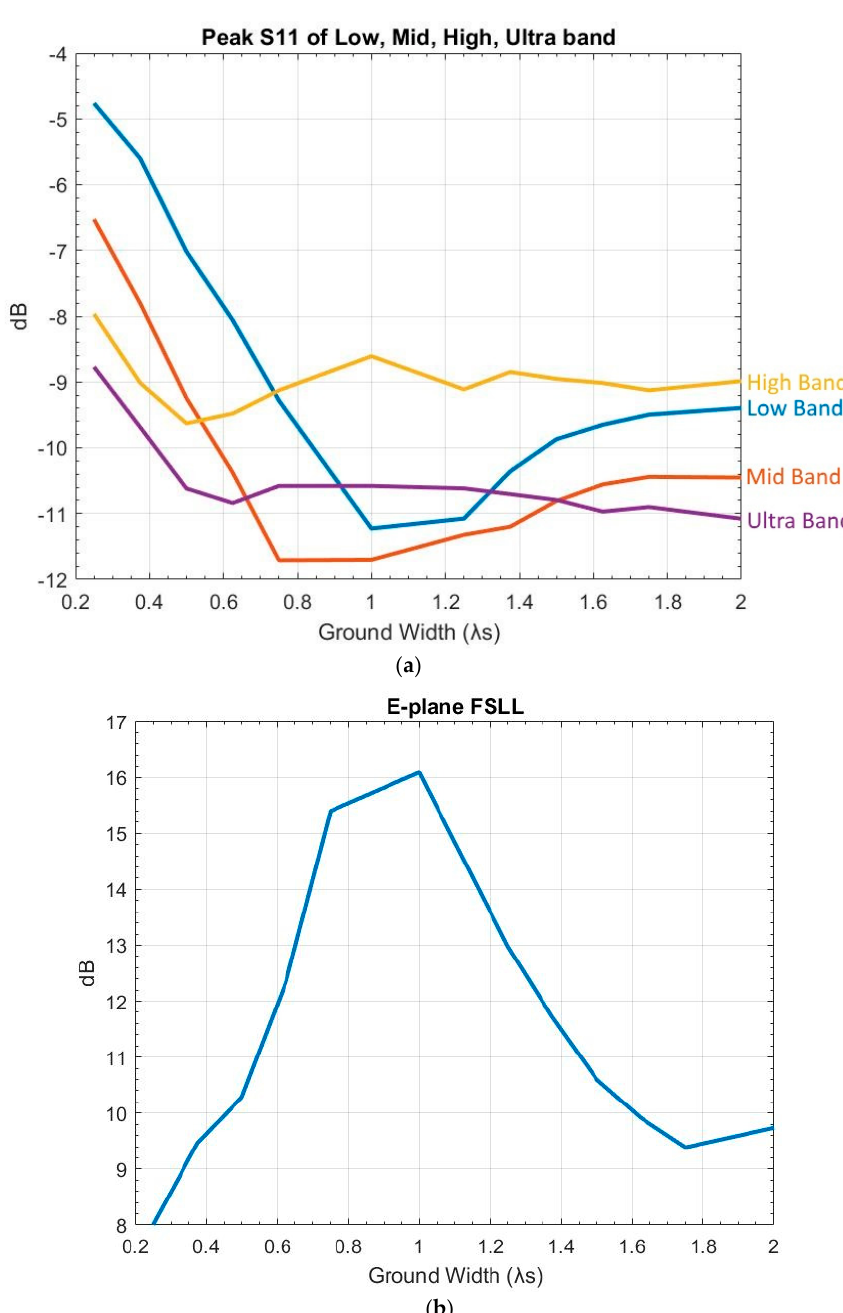
Figure 7. Variation of ground width: ( a ) peak S11 of low, mid, high, and ultra bands (blue: low, red: mid, yellow: high, purple: ultra); and ( b ) E-plane FSLL.